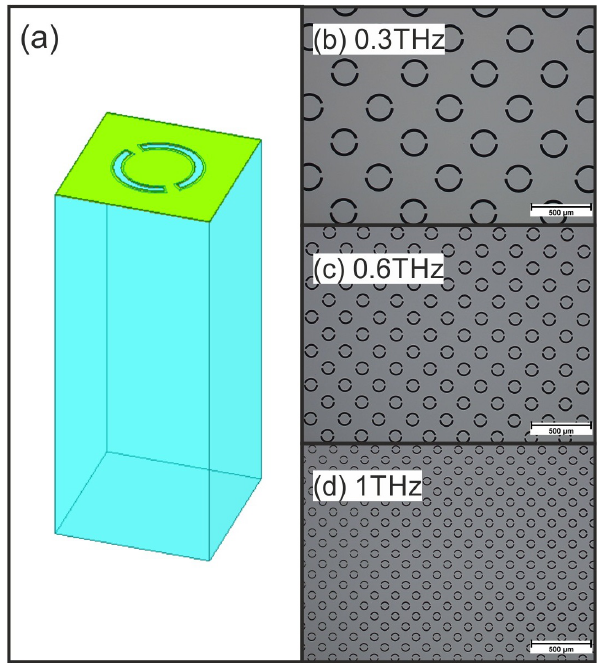
Figure 1. ( a ) Simulation model of the aDSRR structure (for 0.6THz). The structure is scaled from 0.3THz to 0.6 THz by a factor of 2.2 and from 0.6THz to 1 THz by a factor of 1.7. Microscopic images of the fabricated structures for ( b ) 0.3THz, ( c ) 0.6THz and ( d )